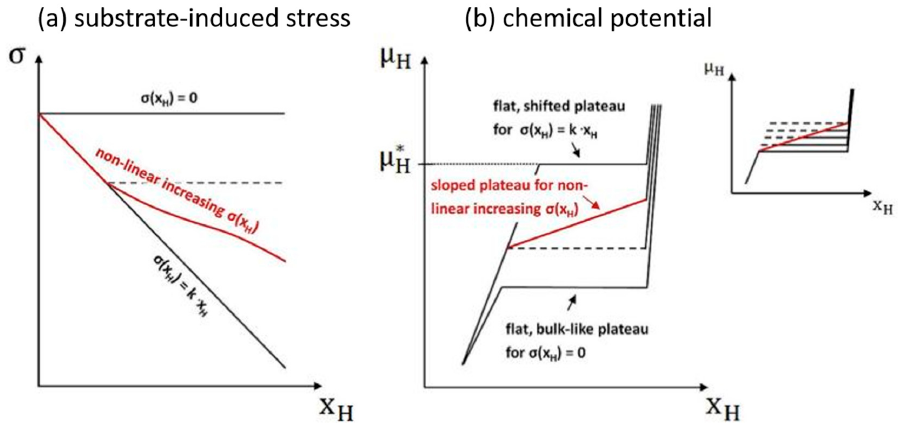
Figure7. E ff ectsofstressonthethermodynamicsofPd-Hthinfilms. Inthepresenceofsubstrate-induced Figure 7. Effects of stress on the thermodynamics of Pd-H thin films. In the presence of substrate- induced stresses linear with concentration, (cid:2026) = (cid:1863) ∙ (cid:1876) (cid:3009) , the transformation to hydride takes place at stresses linear with concentration, σ = k · x H , the transformation to hydride takes place at shifted chemical shifted chemical potential (cid:2020) (cid:3009)∗ compared to bulk Pd. However, if stresses partially relax before (cid:2020) (cid:3009)∗ is potential µ ∗ compared to bulk Pd. However, if stresses partially relax before µ ∗ H plateau is observed. Reprinted with permission from [91] (copyright 2016